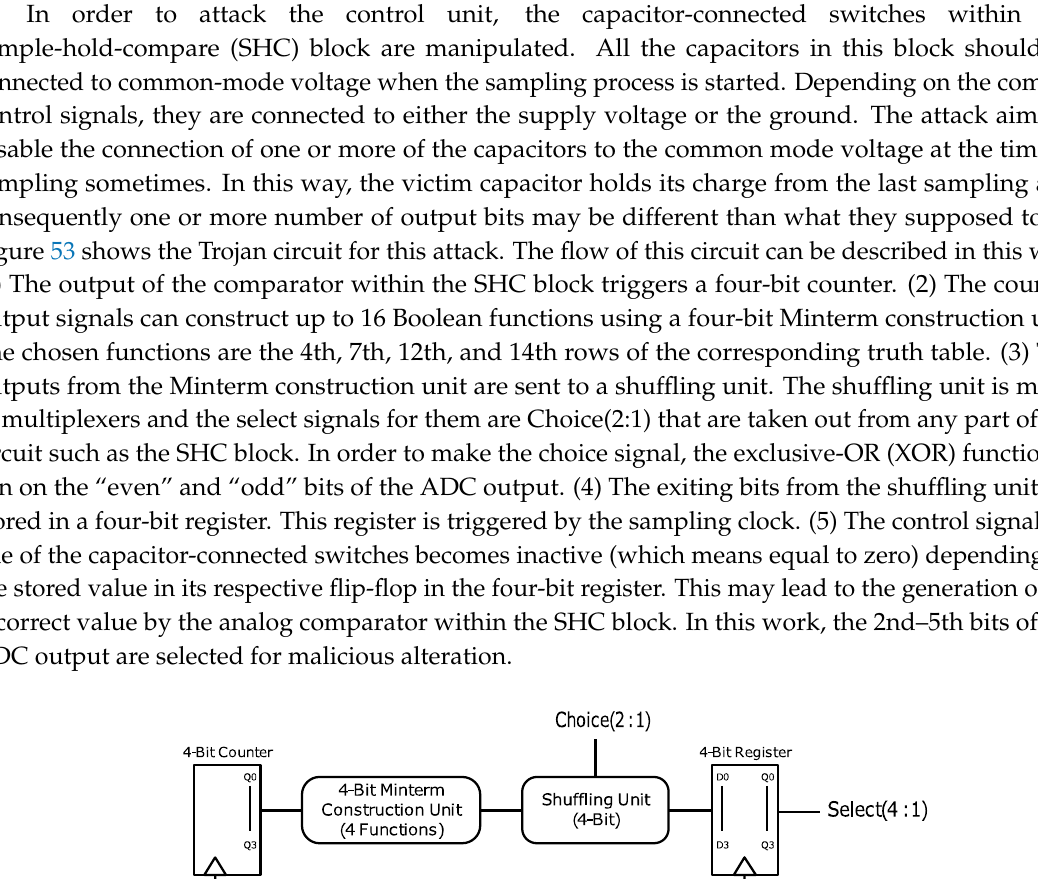
Figure 52. The circuit for the date-path-based countermeasure.